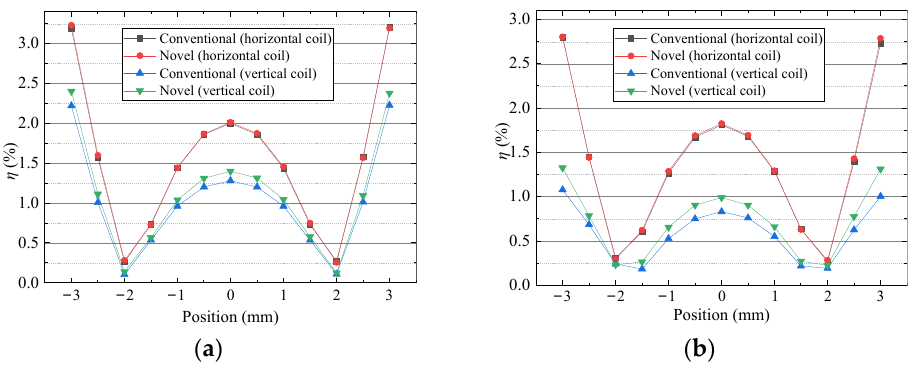
Figure 17. Ripple ratio versus position: ( a ) in x direction ( b ) in y direction. FEM is also used to analyze the driving force when the mover deflects around the z -axis. As shown in Figure 18, the horizontal driving force increase with the deflection of the mover. That is because the windings approach the surface of the pole of permanent magnets and the magnetic field acting on the coils increases. Figure 19 shows that the ripple ratios of the horizontal force of the two schemes are less than 2.6%. The ripple ratio of the vertical force of the new scheme is less than 1.1%, which is better than 2.7% of the conventional one. So, the driving force output is stable when the mover deflects.